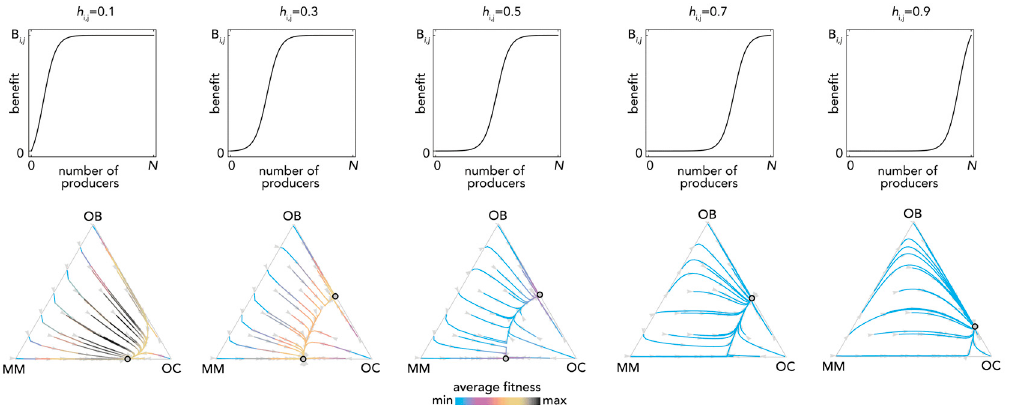
Figure 2. Bistability with nonlinear benefits. The top panels show the benefit function for different values of h i,j . In the bottom panels, the distance from each vertex is inversely proportional to the frequency of each type; arrows show the direction of the dynamics; colors show the average fitness of the population. N = 10; c OC = 0.1; c OB = 0.2; c MM = 0.3; B OC,OC = 0; B OC,OB = 1; B OC,MM = 1.1; B OB,OC = 1; B OB,OB = 0; B OB,MM = 0; B MM,OC = 1.1; B MM,OB = − 0.3; B MM,MM = 0; s i,j = 20.